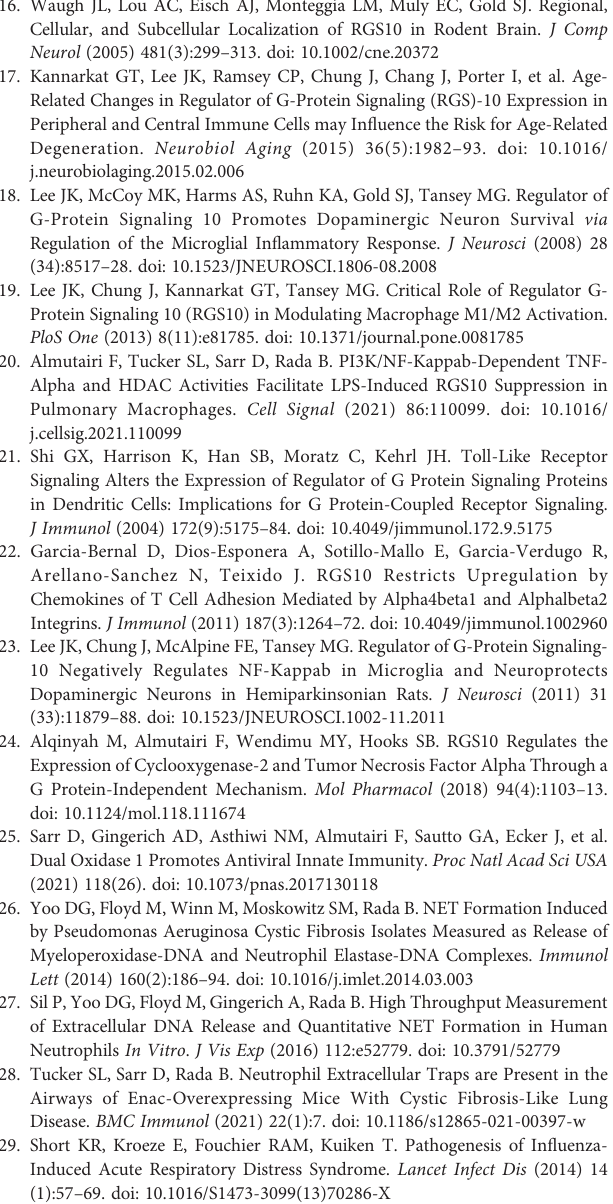
Supplementary Figure S4 | Flow cytometry gating strategy: lymphoid cells. A representative schematic depicting the method for selecting lymphoid cell populations present within the BAL of WT and Rgs10-/- mice. Single cells negative for zombie aqua fi xable viability dye were considered live. CD45+ cells were considered the parent cell population for all cell types measured. The markers used for each cell type are as follows: T cells (CD45 + , CD3 + ), CD8 T cells (CD45 + , CD3 + ,